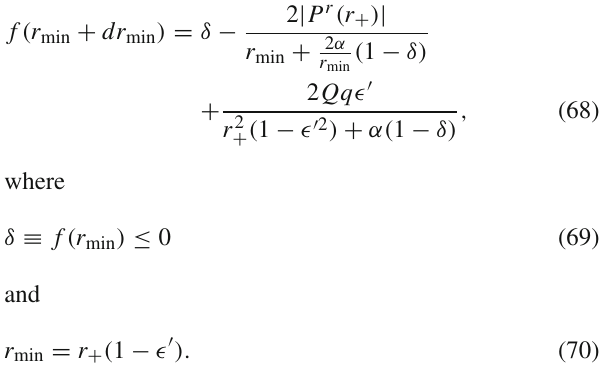
Fig. 1 Energyboundsforthechargedparticle δ E max (blacksolidlines) and δ E min (red dashed lines) vs. charge of the particle δ Q for extremal and near-extremal 4 D charged EGB black hole for positive coupling constant. Where we have choose the mass M = 2 for the black hole, the